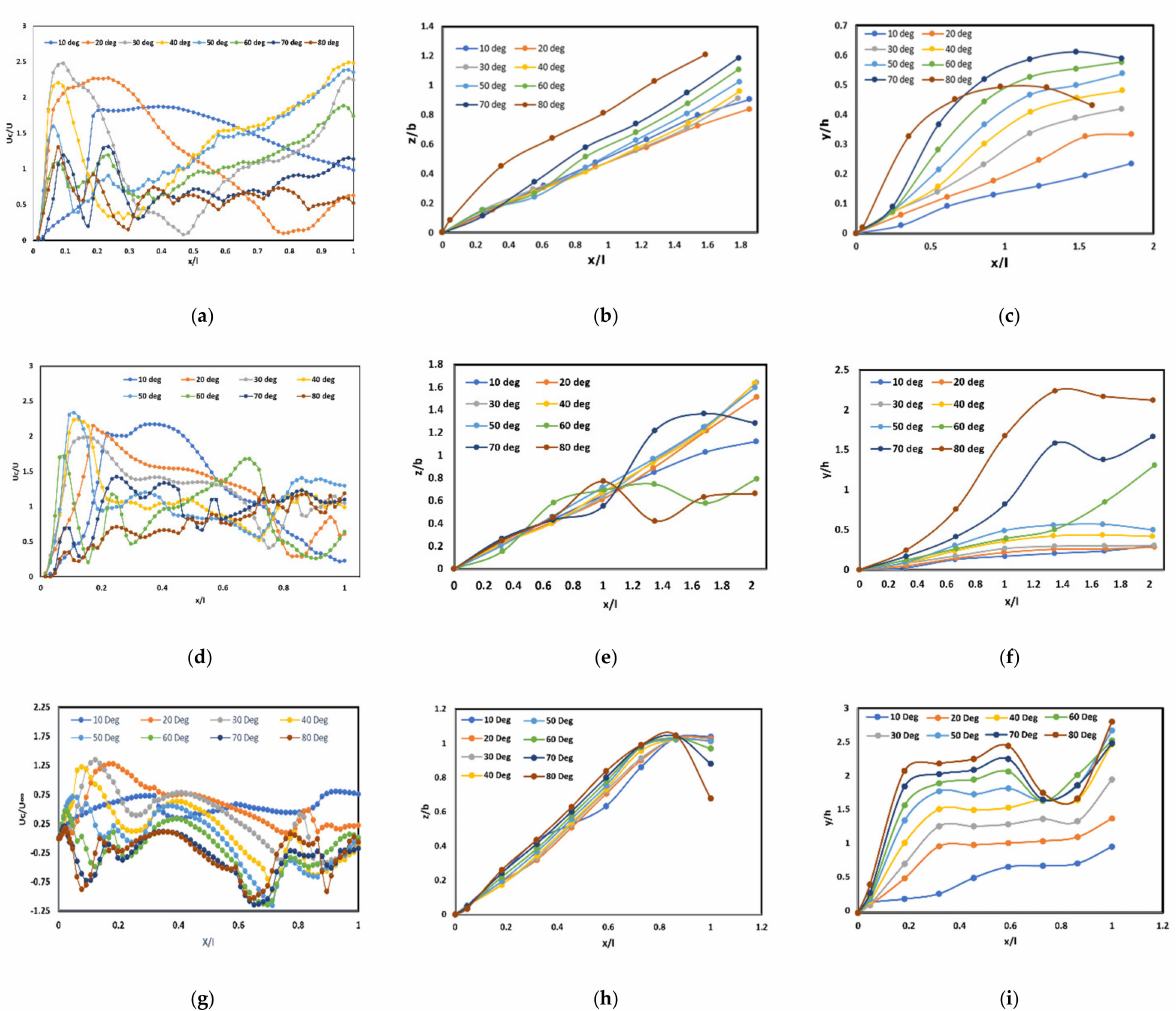
Figure 11. Nondimensional (ND) velocity distribution (Uc/U ∞ ) and trajectory in the vortex core (VC); ( a ) The ND velocity of J-10; ( b ) Spanwise vortex core of J-10; ( c ) Vertical trajectory VC of J-10; ( d ) The ND velocity of SU-30; ( e ) Spanwise vortex core of SU-30; ( f ) Vertical trajectory VC of SU-30; ( g ) The ND velocity of EF-T; ( h ) Spanwise vortex core of EF-T; ( i ) Vertical trajectory VC of